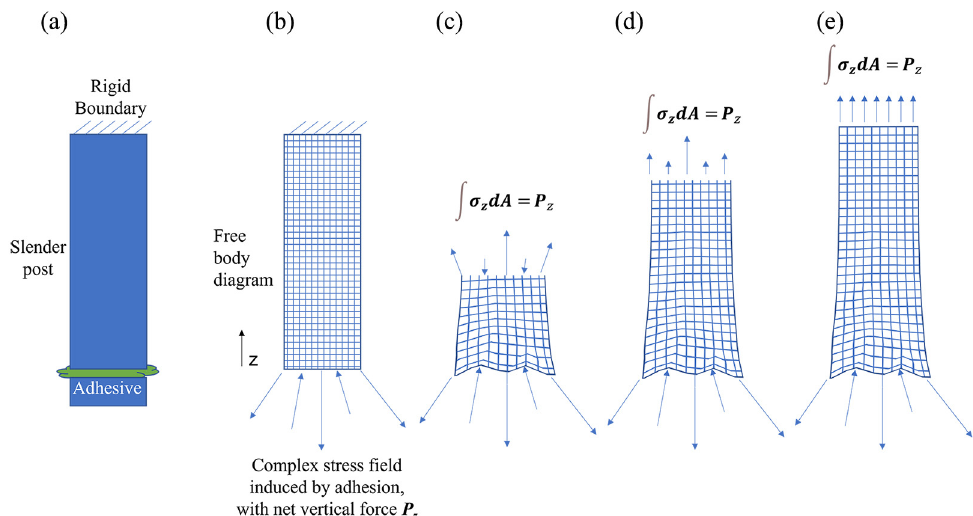
Figure 1. Schematic cross-section illustrating the proposed approach to mitigate complex stresses due to adhesion interfaces. ( a ) A post is suspended from a rigid boundary and has an adhesive interface some distance from the boundary. ( b ) A complex stress state with regions of stress concentration is shown in a free-body sketch of the bottom of the post. The net force is equal to the integral of stresses evaluated over the post cross-sectional area. ( c ) Near the adhesive interface, the resultant stresses on an interior cross-section of the post are still complex. ( d ) At interior cross-sections further away from the adhesive interface, the resultant stresses become more uniform. ( e ) Far from the plane of imposed adhesive stress, the stress state is nearly uniform. In all interior sections, the net force is equal and opposite the force at the interface, as required by static